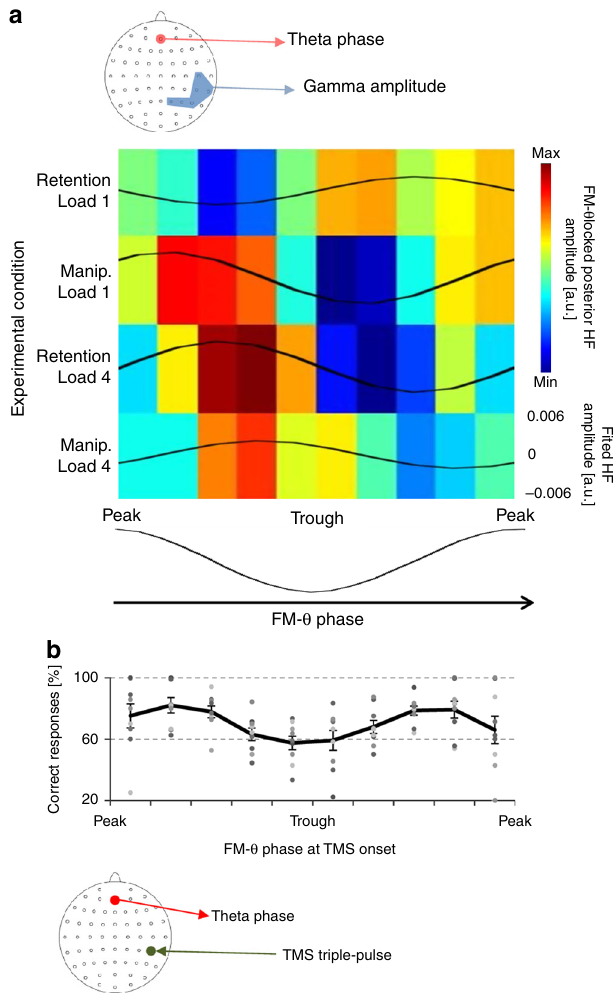
Fig. 2 Task-dependent nesting of posterior gamma band activity into FM-theta waves and FM-theta phase-speci fi c TMS effects. a FM-theta phase-locked right temporo-parietal gamma amplitude (experiment 1) during the delay period. Mean z-transformed gamma amplitude from electrode sites within the blue-shaded area in the headmap is represented as a function of FM-theta phase extracted from electrode site AFz. Warm colors indicate stronger gamma amplitude. On the x -axis ten FM-theta phase bins covering one complete FM-Theta cycle are shown. The four lines of the y -axis represent the four experimental conditions ordered according to task dif fi culty. Note that the more cognitive control an experimental condition required (retention load 1 < manipulation load 1 < retention load 4 < manipulation load 4) the more was posterior gamma activity nested into the through of FM-theta phase. b Effect of right temporo-parietal triple-pulse rTMS on task accuracy for manipulation of four items (experiment 2). The strength of the disruptive effect of rTMS depends on instantaneous FM-theta phase at onset of stimulation. When posterior rTMS is applied close to the trough of FM-theta — the sensitive phase into which EEG gamma activity is nested in this condition during experiment 1 — mean accuracy rates drop close to chance level. The ten FM- theta phase bins on the x -axis are aligned to FM-theta phase from a . Dots represent single subject data. The line graph represents sample mean values with standard error of mean as error